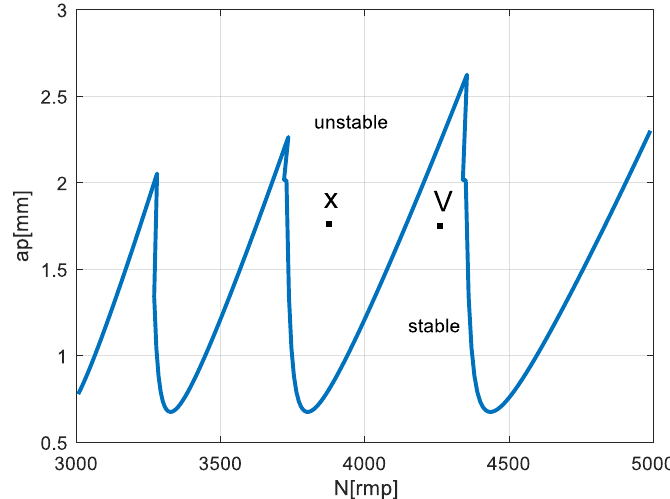
Figure 4. Cutting-speed selection problem in a stability lobes diagram.